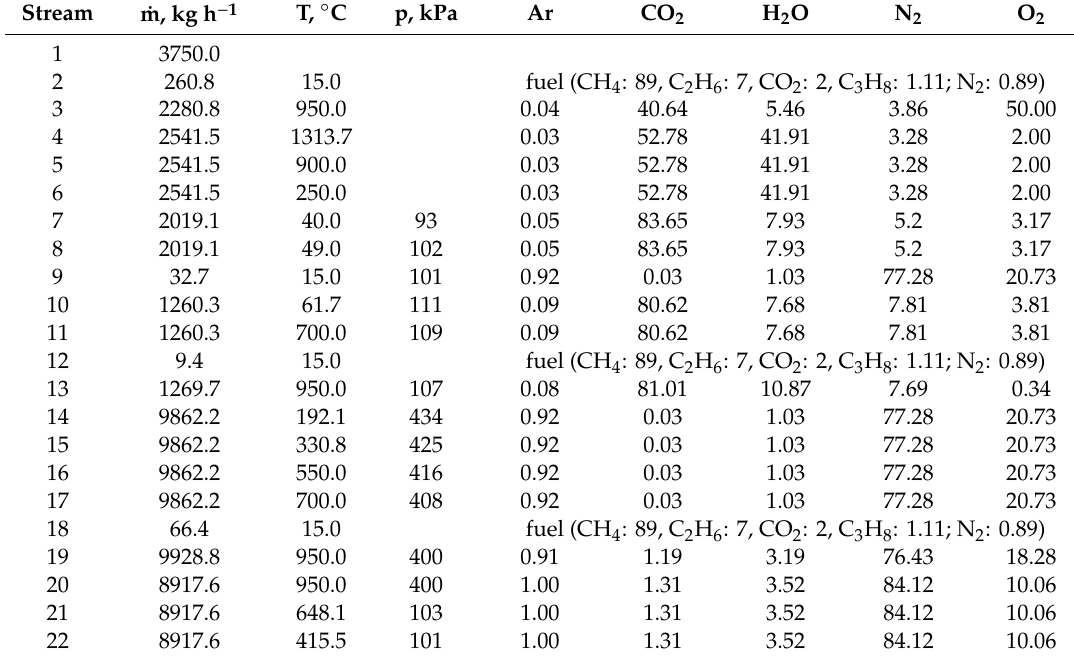
respectively, whereas a net power of 374.2 kW has been calculated for the micro-gas turbine system. Table A4. Mass flow rates, temperatures, pressures and compositions (mol.%) at the main stations in Figure 14 for a glass melting furnace with production of 90 ton day − 1 .